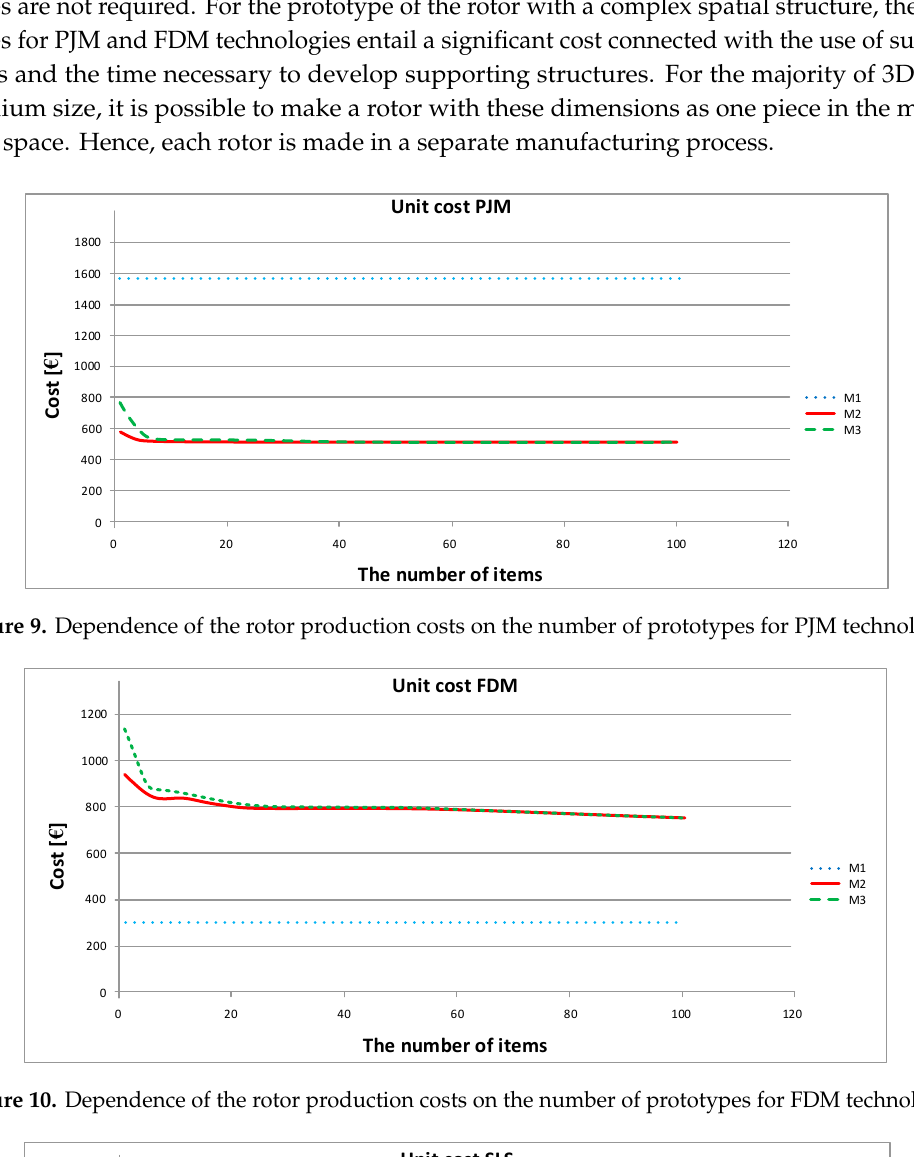
Figure 8. 3D-STL models of the test elements: ( a ) rotor; ( b ) bracket.